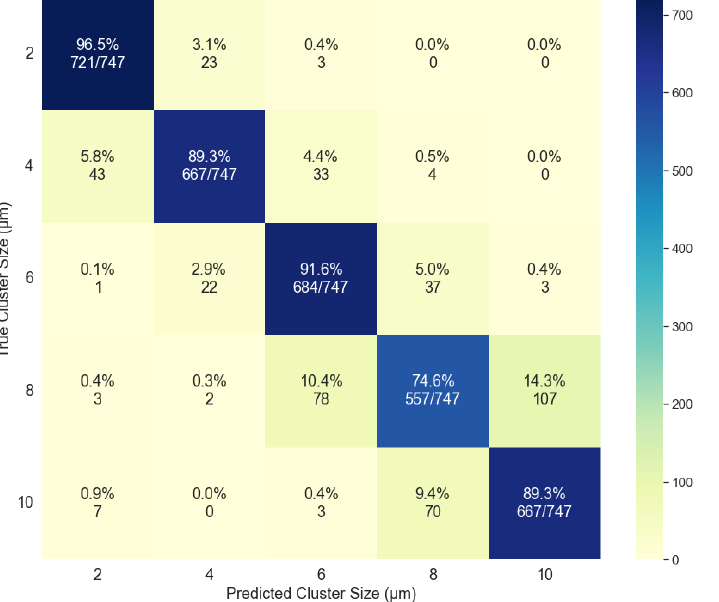
Figure 9. Confusion matrix for the classification based on cluster size using the backward scattering data for the